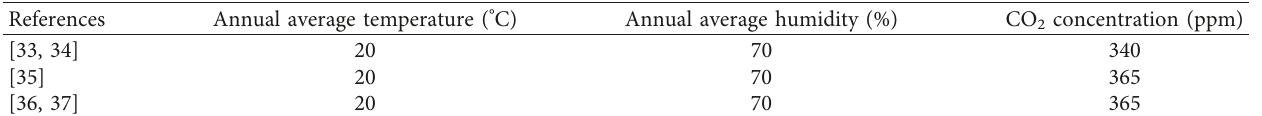
Figure 15: Comparative test results and simulation results ( X q ) at other positions: (a) C25 concrete ( X q ); (b) C30 concrete ( X q ); (c) C35 concrete ( X q ). Table 5: Environmental factors in